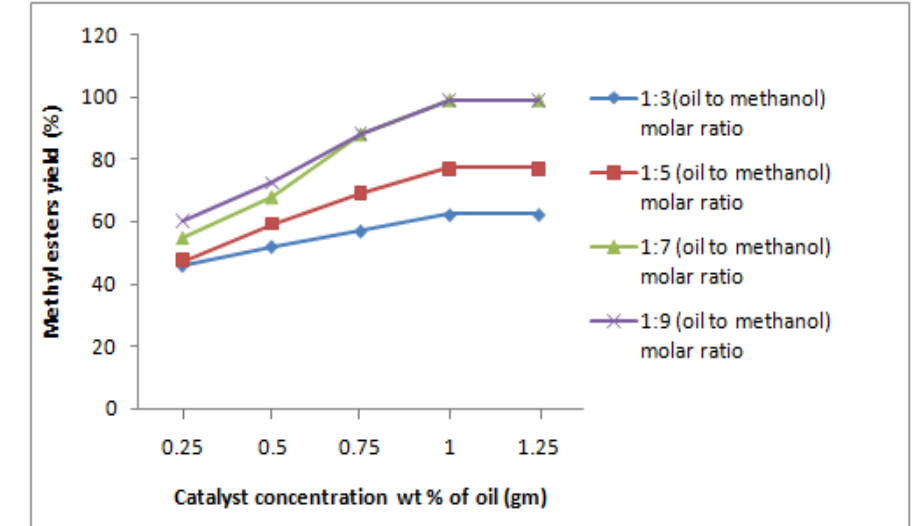
Figure 1. Effect of catalyst concentration (wt% of oil) and molar ratio (oil:methanol) on the yield of methyl esters from coconut oil (at constant temperature of 65 °C, flow rate of 142 mL/min, stirring speed of 800rpm, residence time 21.04